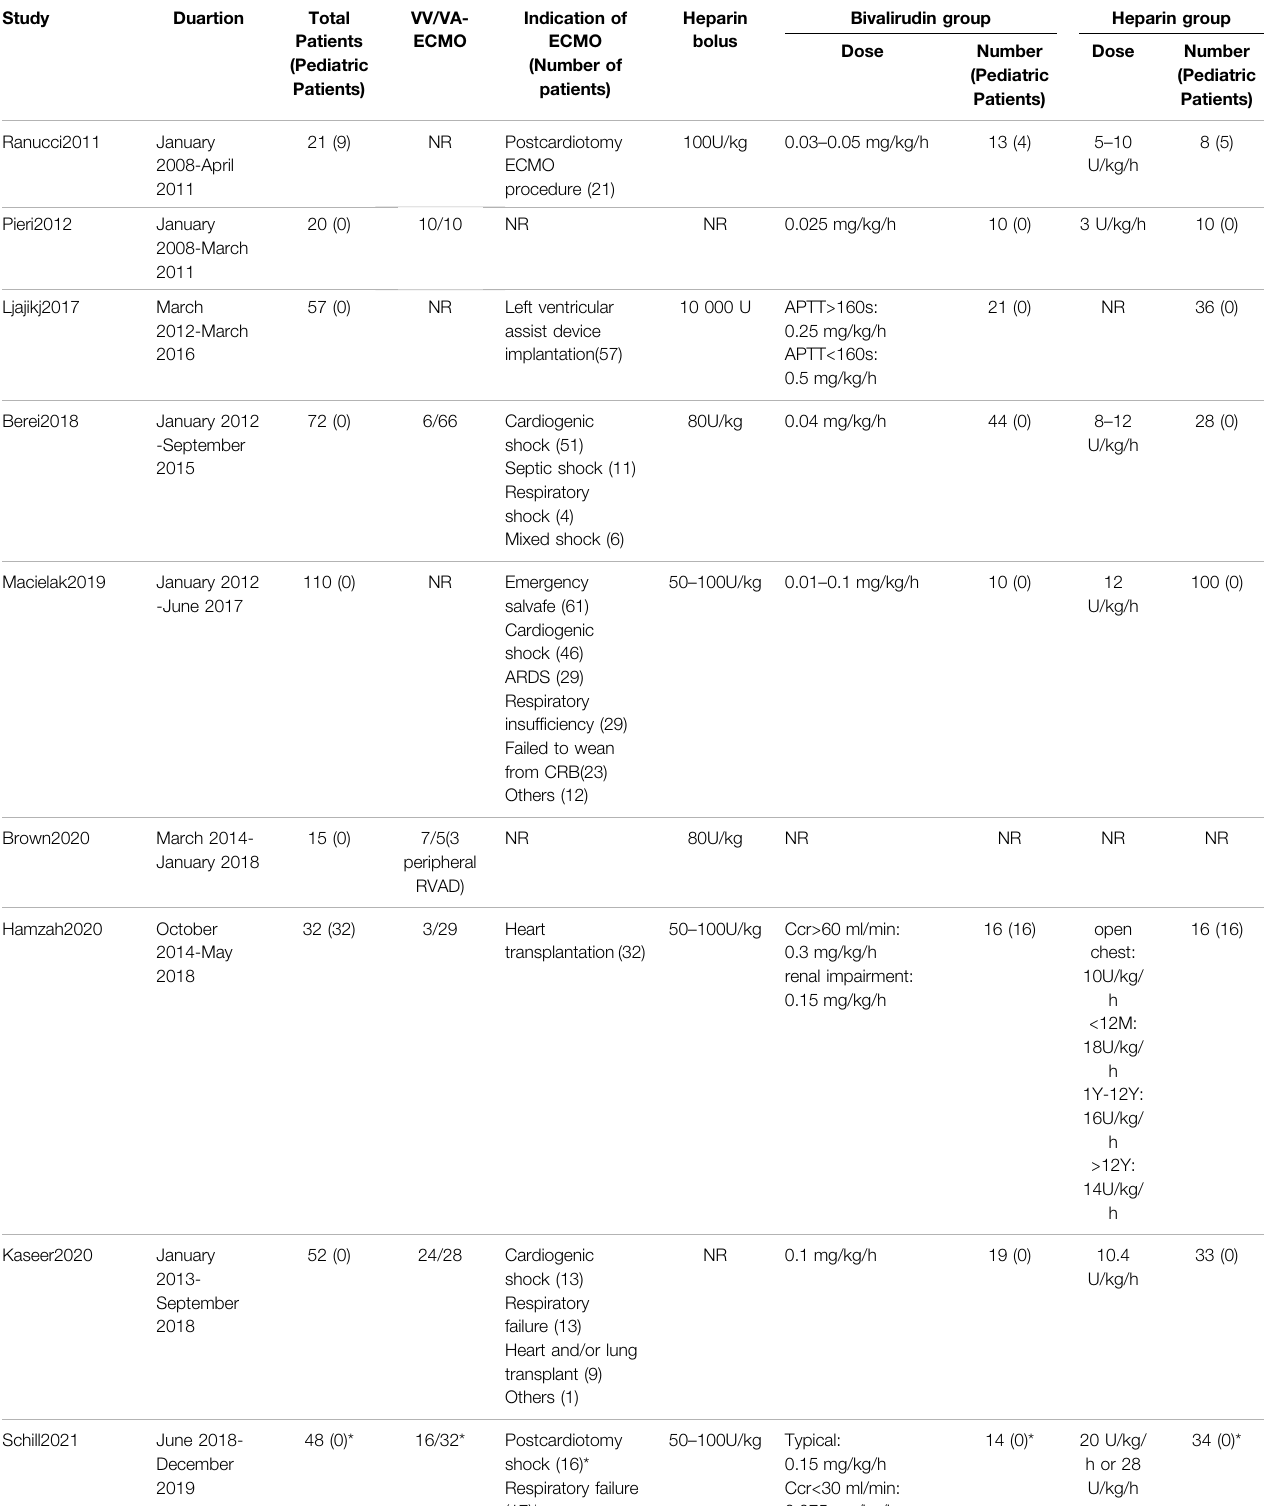
TABLE 2 | Basic information of the included